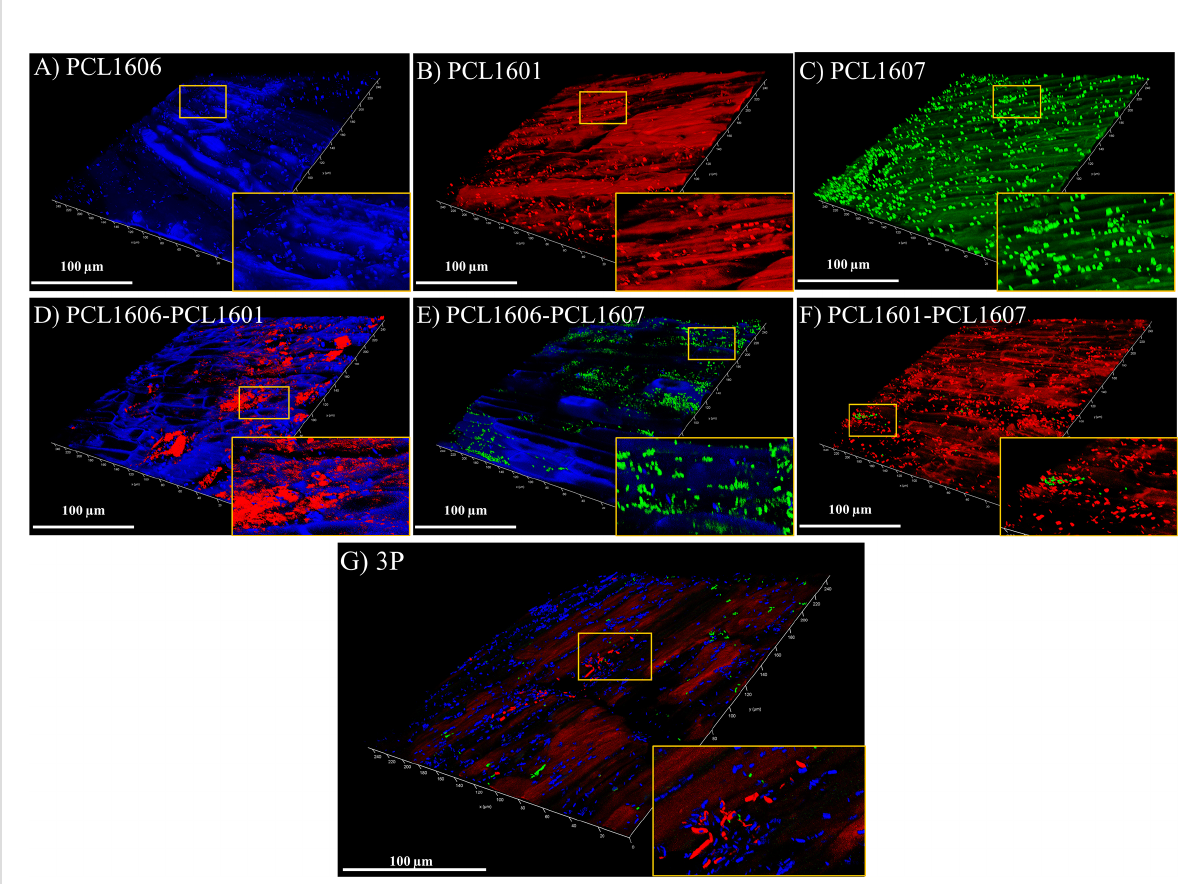
FIGURE 7 Bacterial distribution pattern on avocado roots after 24 h visualized under confocal laser microscopy. Single-strain bio fi lms (A – C) are shown: P. chlororaphis PCL1606 (in blue); P. chlororaphis PCL1601 (in red); and P. chlororaphis subsp. piscium PCL1607 (in green), as well as the dual and 3P combinations (D – G) . Yellow squares shown in the bottom right corner images correspond to areas magni fi ed three times. Scale bars represent 100 µm. 3P: Three-strain